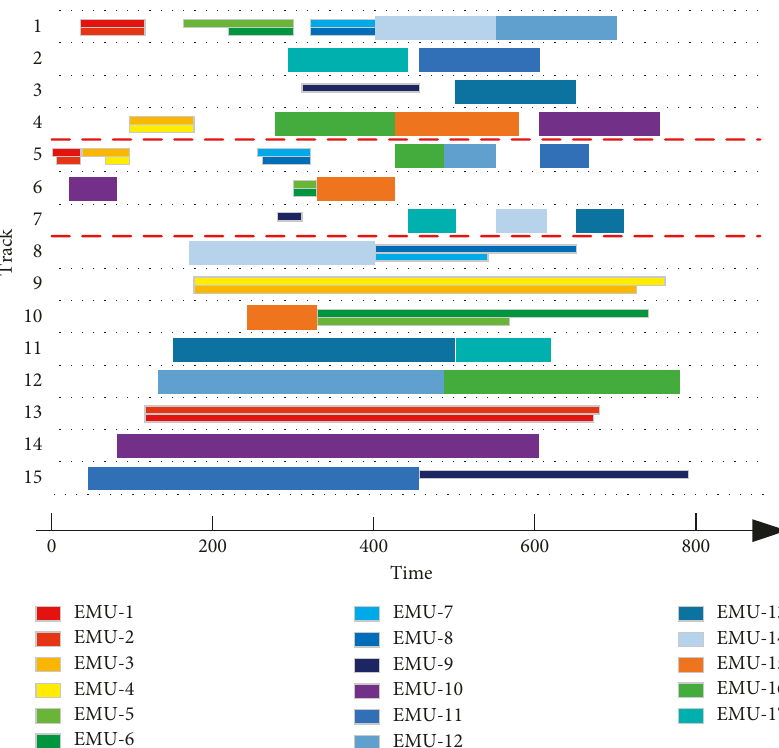
Figure 10: A Gantt chart representation for the optimized shunting plan at a stub-end EMU depot generated by the RVNS algorithm.